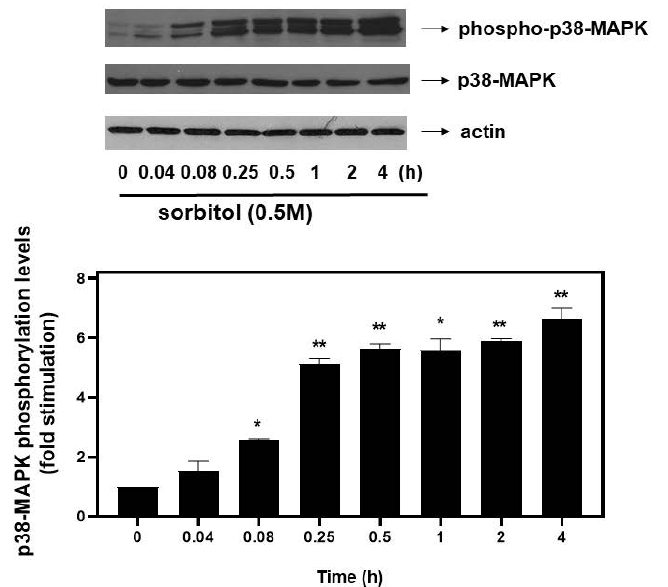
Figure 4. Time-dependent profile of hyperosmotic-stress-induced p38-MAPK phosphorylation in H9c2 cardiac cells. H9c2 cells were exposed to 0.5 M sorbitol for the times indicated. Protein extracts (40 µ g/lane) were subjected to SDS-PAGE and immunoblotted with antibodies for phosphorylated p38-MAPK ( upper panel), for total levels of p38-MAPK ( middle panel) and for total actin levels ( bottom panel). Western blots presented are representative of at least three independent experiments with overlapping results. Immunoreactive bands were quantified by scanning densitometry and plotted (respective graph). Results are means ± SEM for at least three independent experiments. * p < 0.05 and ** p < 0.01 compared to control